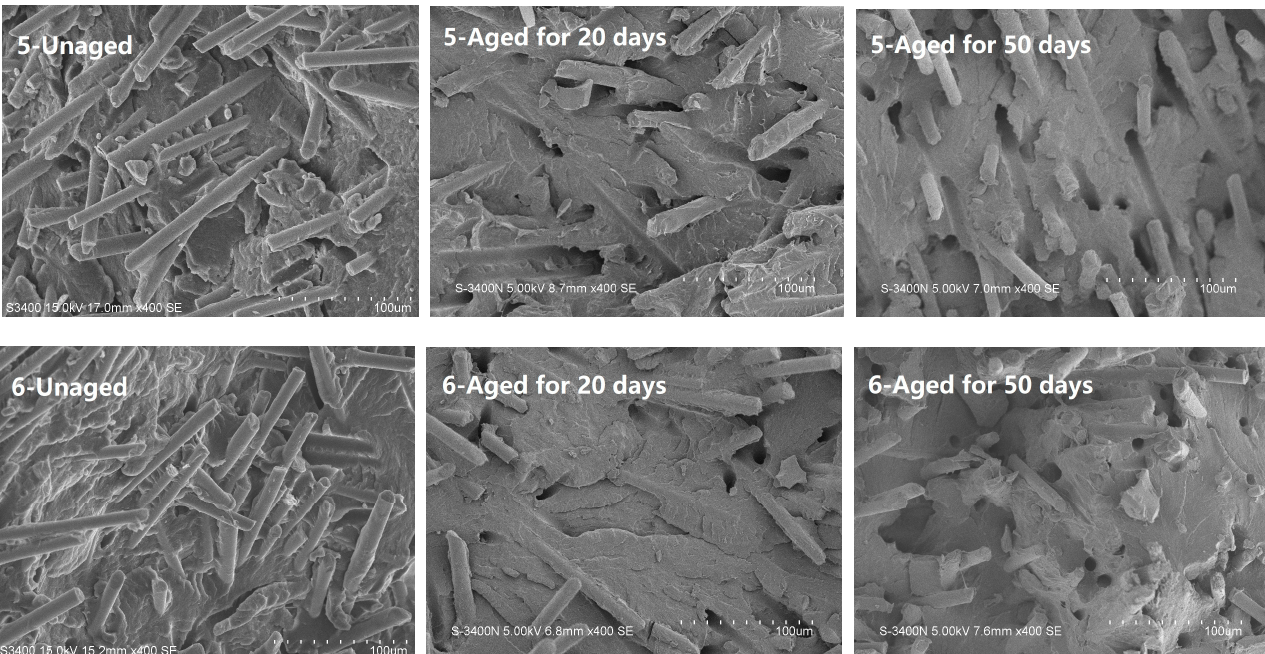
Figure 9. SEM images of the fracture surfaces of the unaged and aged PA56T/GF samples at 400× magnification.